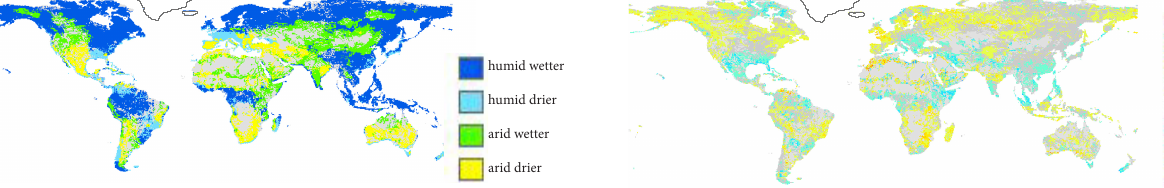
Fig. 6. Map showing the number of months change in the timing of peak discharge occurrence calculated by taking the mode of the ensemble of timings calculated for the twelve individual GCMs for the scenario A1B relative to to 20C3M control experiment.